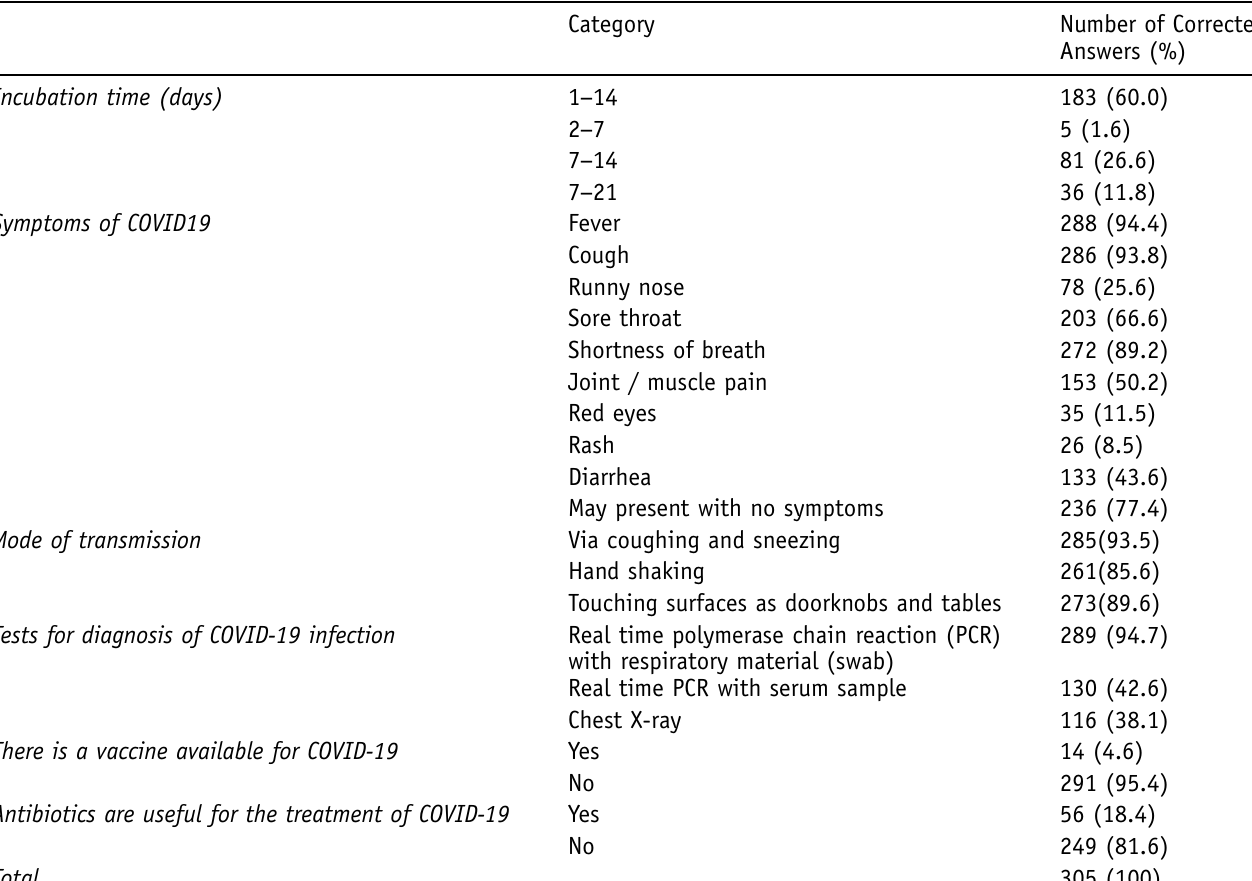
Table II. Knowledge of dental students about COVID-19.